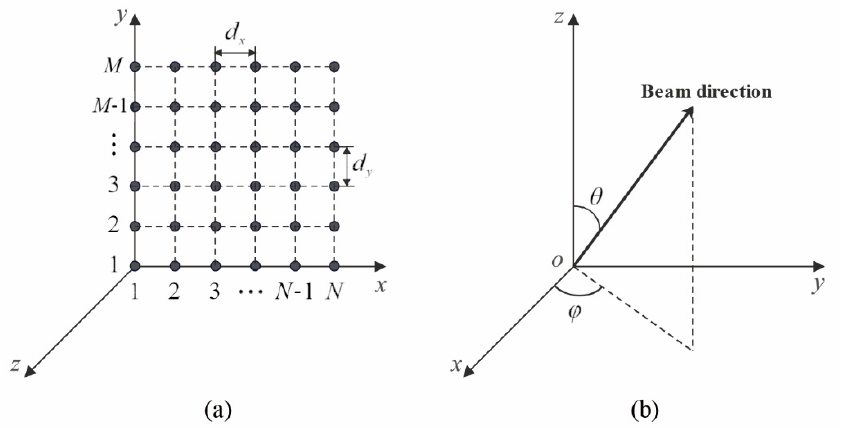
Figure 5. Diagrams of the rectangular planar phased-array antenna. ( a ) Array elements. ( b ) Coordi- nate system.